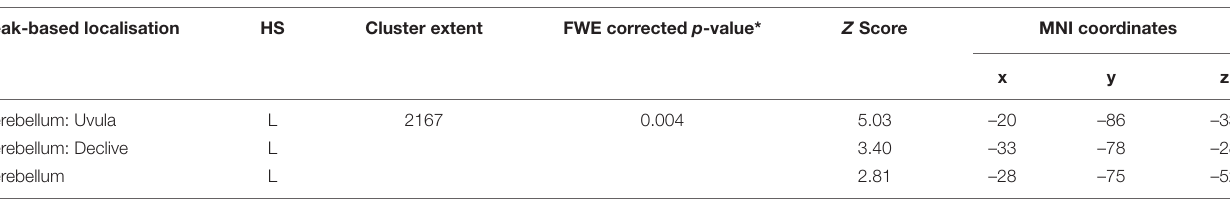
FIGURE 3 | Regions that displayed a positive correlation between the SET-EA scores and grey matter volume. TABLE 5 | Grey matter clusters of significant correlation for the